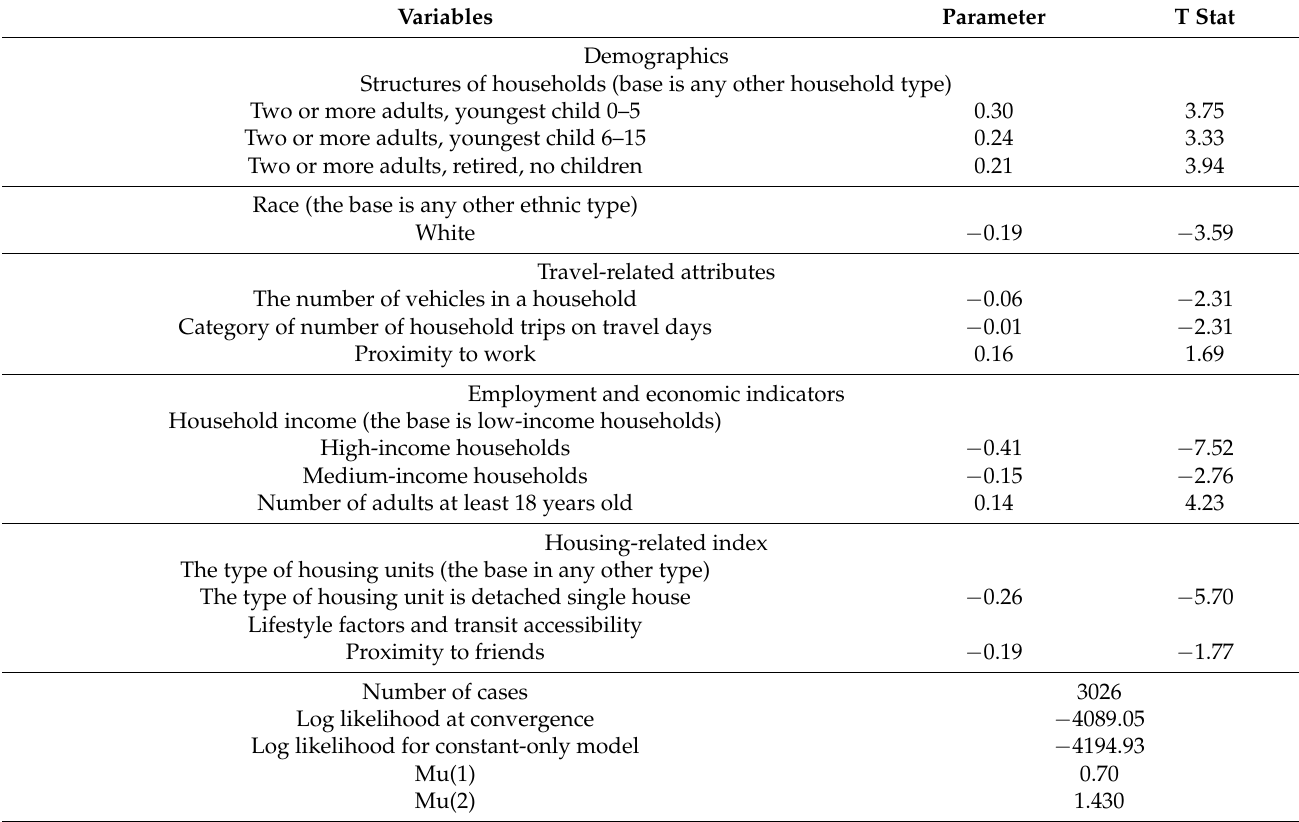
Table 6. Ordered response model of residential choice of population density at census block level.